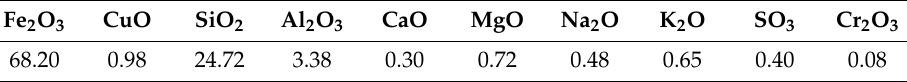
Table 1. Main chemical composition of copper slag (wt.%).